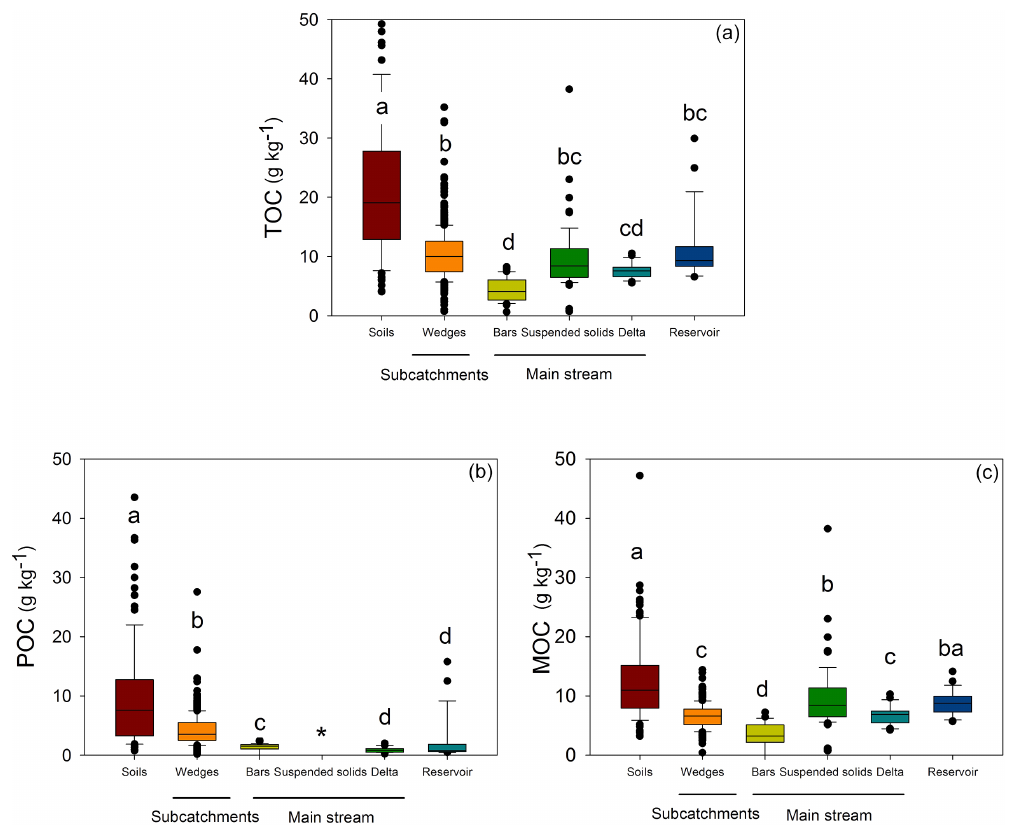
Figure 4. Median, percentiles (10th, 25th, 75th and 90th) and error of the total organic carbon concentration (TOC) (A) , particulate organic carbon (POC) (B) , and mineral associated organic carbon (MOC) (C) of soils and sediments within the Turrilla catchment. Different let- ters (a–e) indicate significant differences according to the Kruskal–Wallis test ( p < 0.05). ∗ – the suspended solids measured contained only the MOC